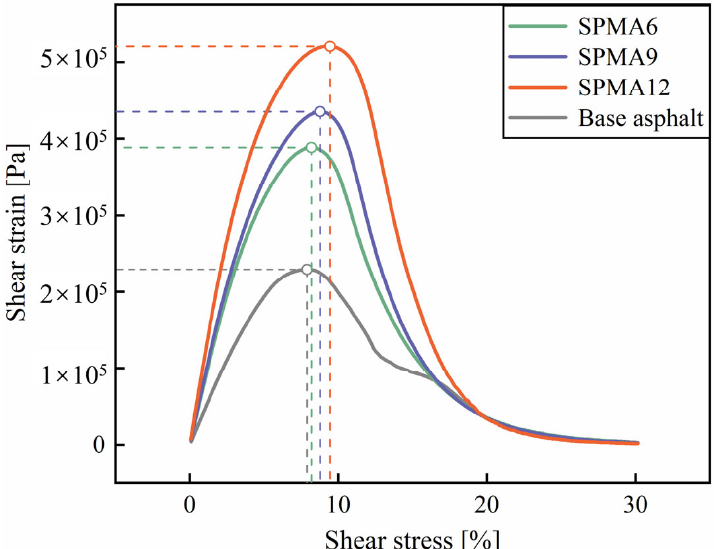
Figure 15. Stress–strain curve of asphalt binders.